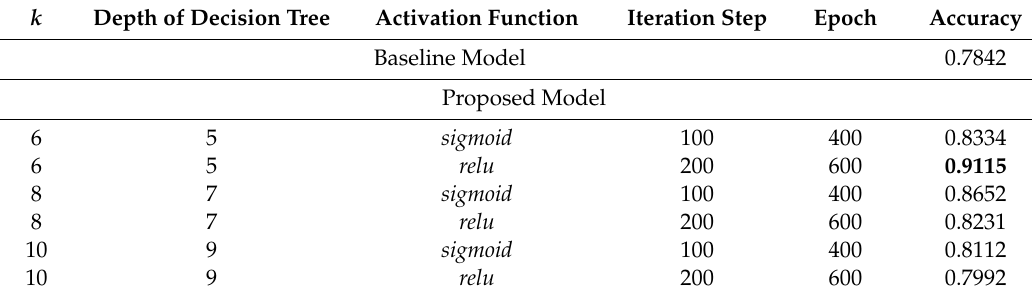
Table 2. Experimental results of the DDTree Model (best value is shown in bold).